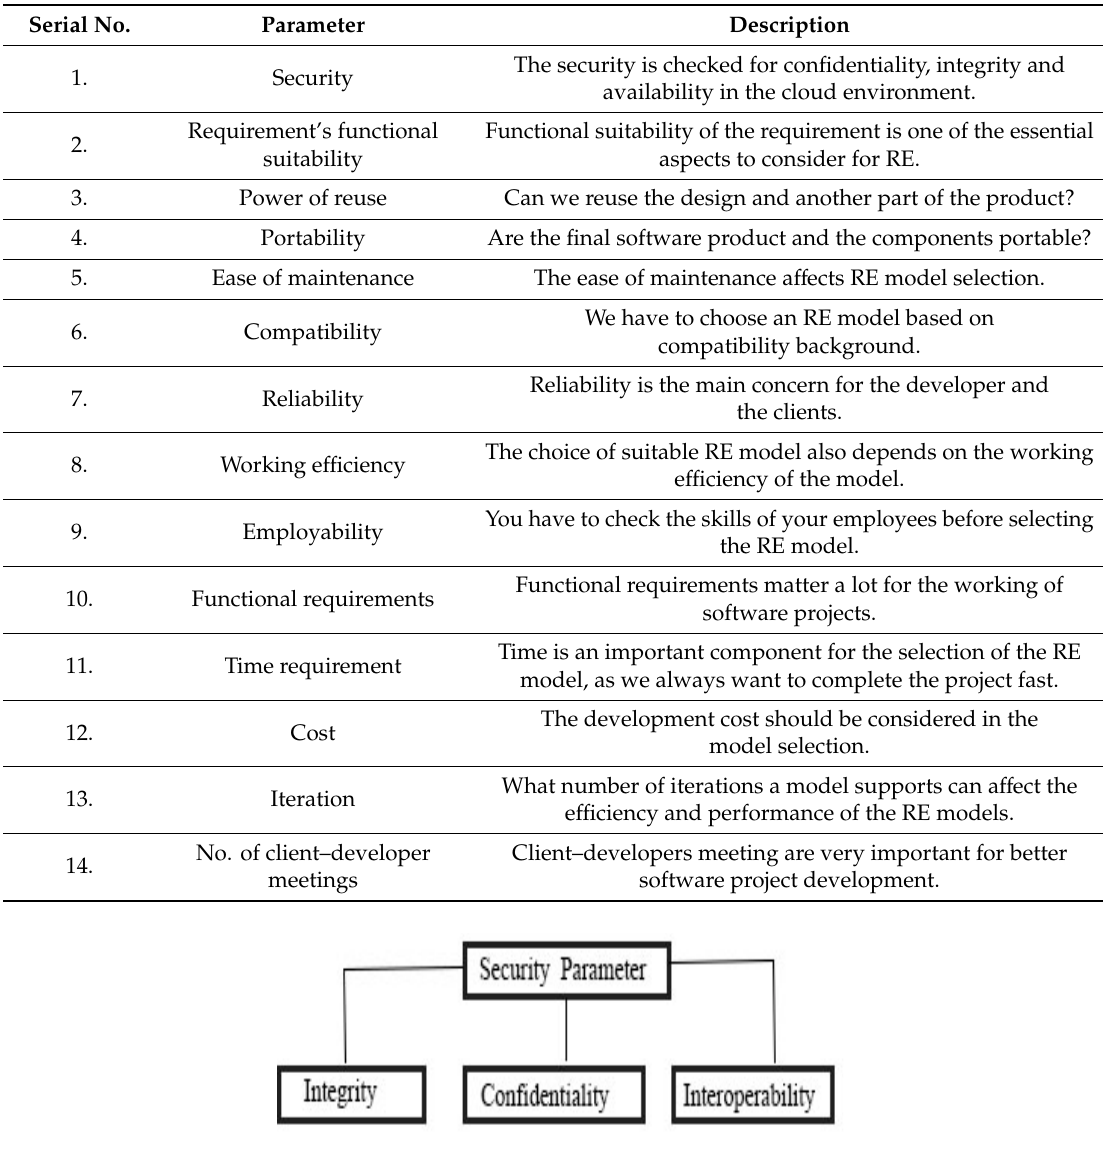
Table 1. Classification factors of RE model .